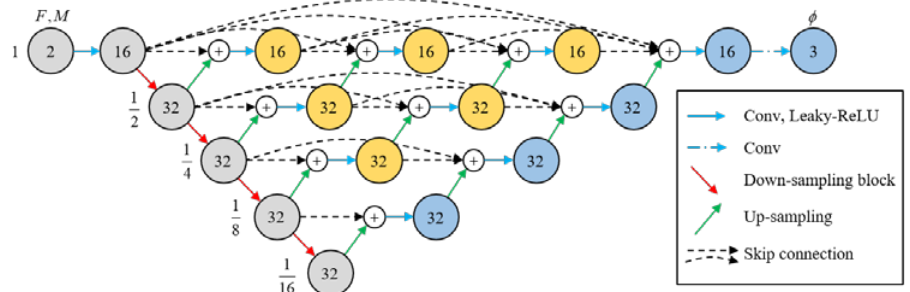
Fig. 1. Overview of the registration framework for CBCT to CT deformable image registration.